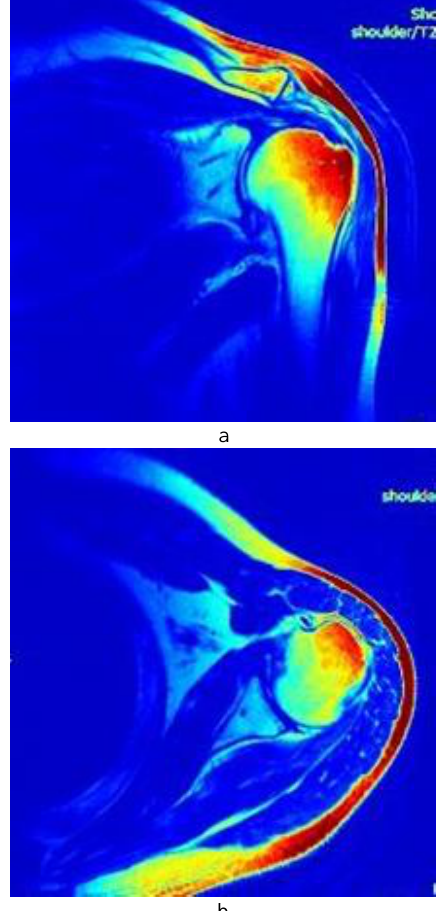
Figure 1. An example of visualization of MRI images after surgery. a – frontal view, b – axial view of the MRI of the shoulder joint after Latarget plasty The function of the shoulder is the result of a complex interaction between the work of the bone and soft tissue components, passive and active stabilizers. When moving in the shoulder-shoulder joint, the head of the humerus should exert pressure on the glenoid of the scapula with a relatively constant force and, due to the coordinated work of the muscles, maintain a central position throughout the entire range of motion and at any effort. This is important to take into account when assessing X-ray anatomy, biomechanics and a comprehensive study of the interaction between these stabilizing systems (Dickens et al.,